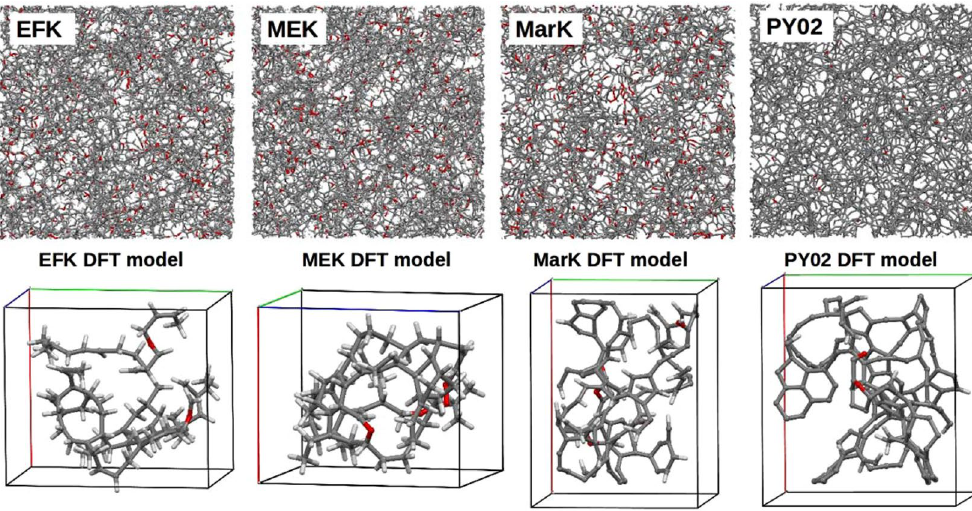
Figure 3. Structures of the EFK, MEK, MarK and PY02 models (Top; cubic box size of 50 × 50 × 50 Å 3 ); representative 3D-periodic portions of EFK, MEK, MarK and PY02 models used in the present DFT/DFPT calculations at the GGA/PBE level (Bottom); simulations cells are indicated by solid lines). Color legend: grey, C; white, H; red, O.